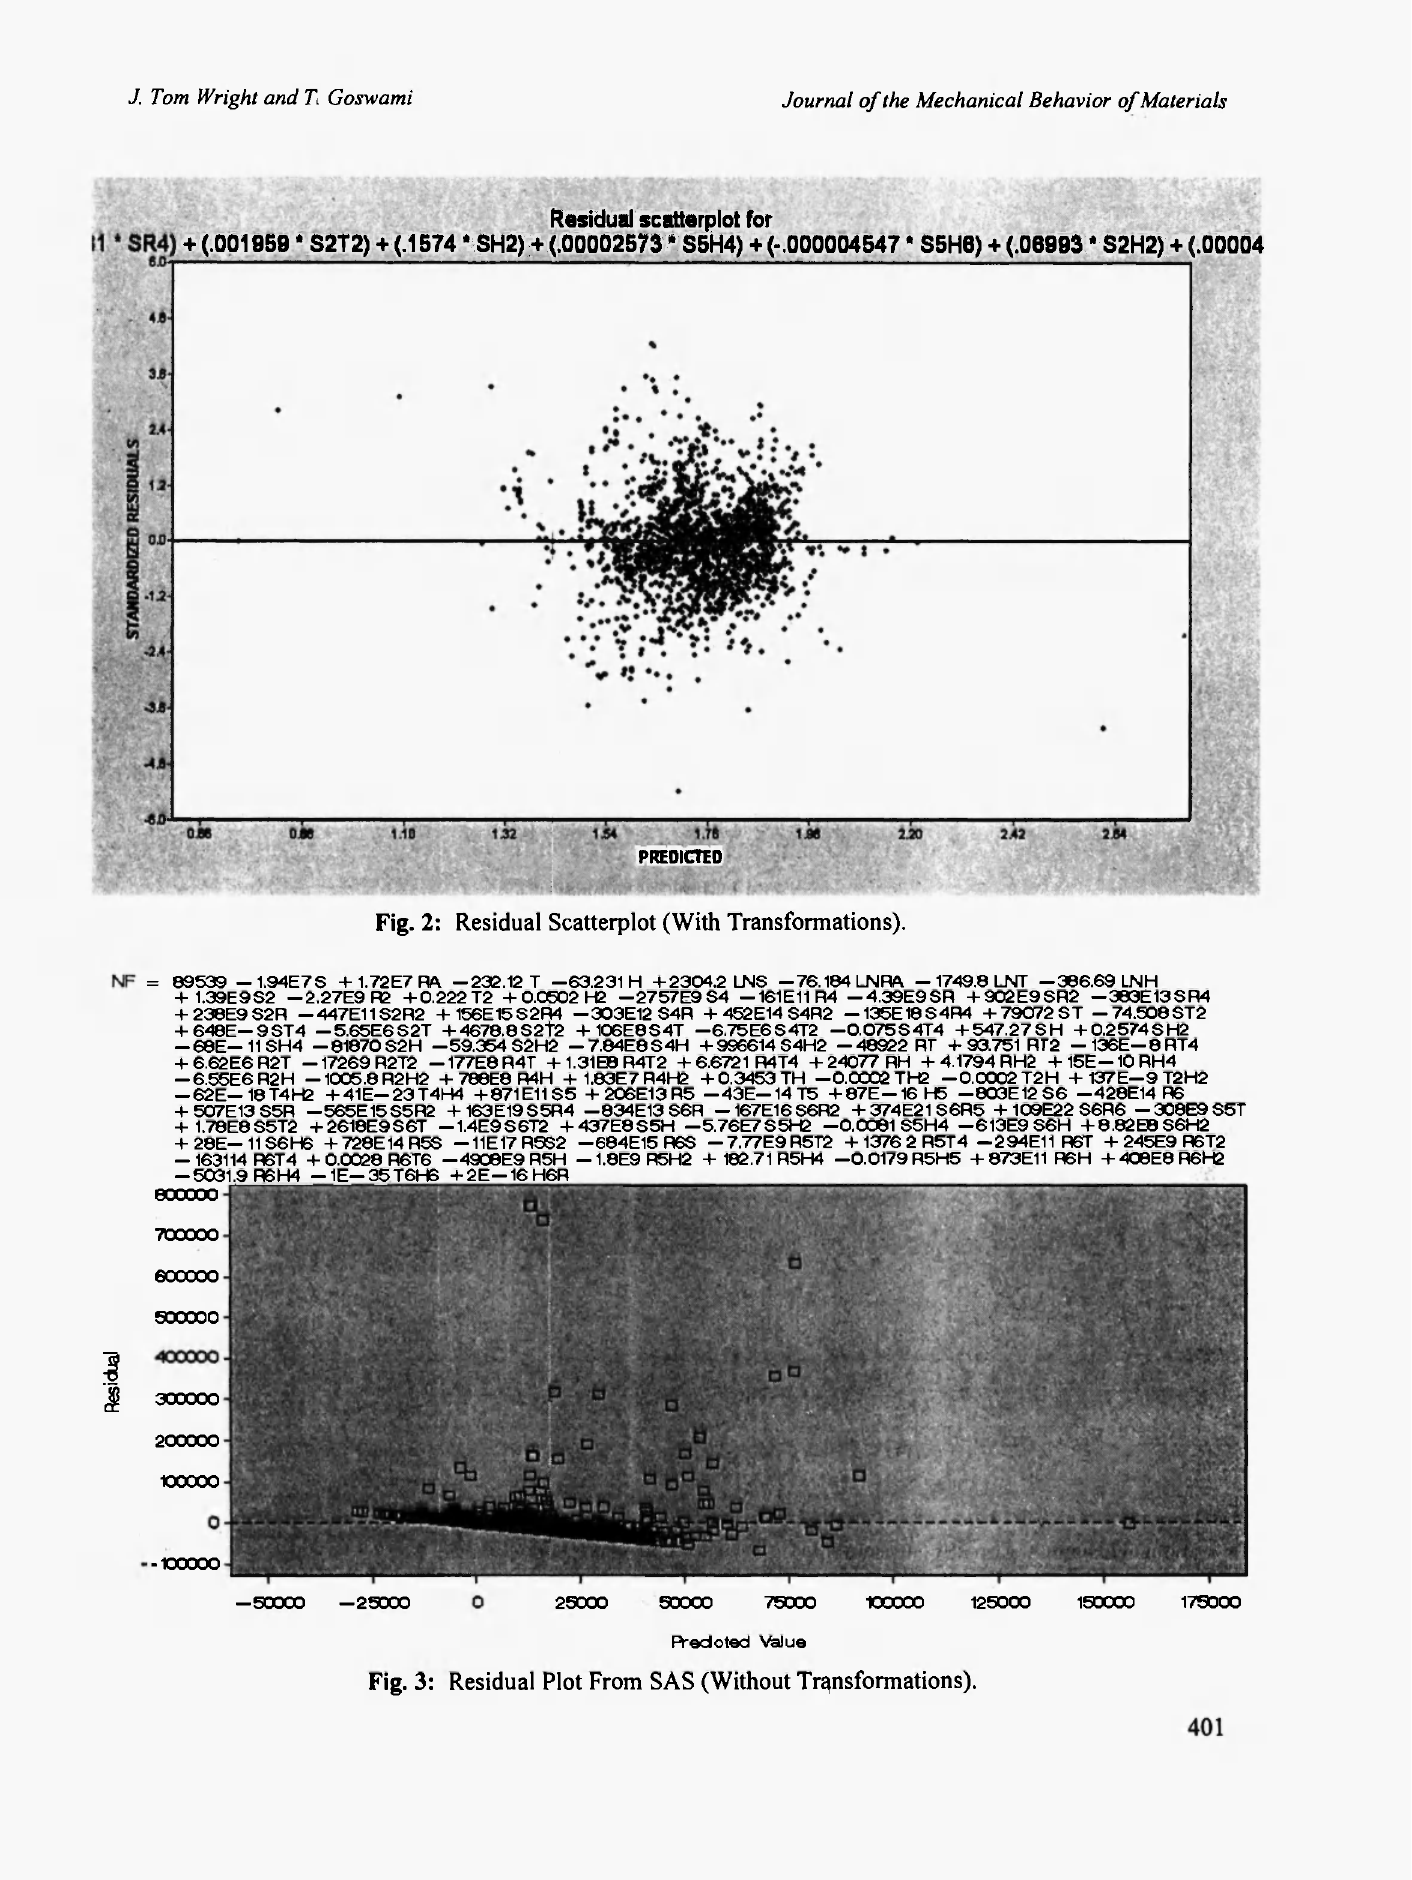
Fig. 3: Residual Plot From SAS (Without